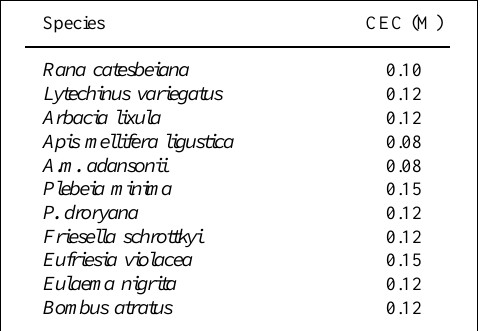
Table II - CEC values for sperm chromatin DNA-protein complexes.